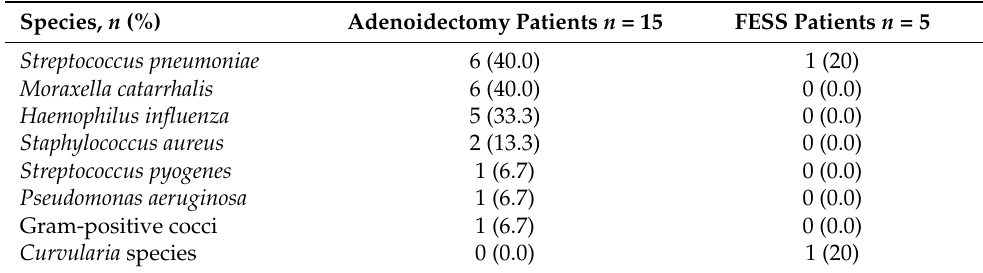
Table 2. Microbial species identified from patients undergoing adenoidectomy and functional endoscopic sinus surgery (FESS) in the Johns Hopkins All Children’s Hospital (JHACH) cohort. Species, n (%) Adenoidectomy Patients n = 15 FESS Patients n =